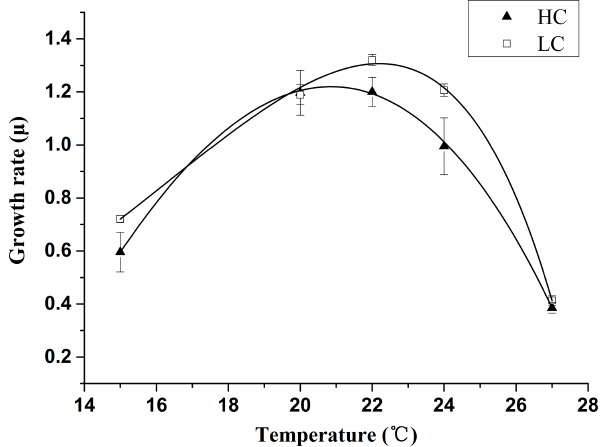
Figure 1. Thermal reaction norms of E. huxleyi grown in 400µatm (LC) and 1000µatm (HC) CO 2 concentrations. The corresponding R 2 values are 0.996 (LC) and 0.999 (HC), respectively. The values are the means, and the error bars are standard deviations for tripli- cate cultures for each treatment.